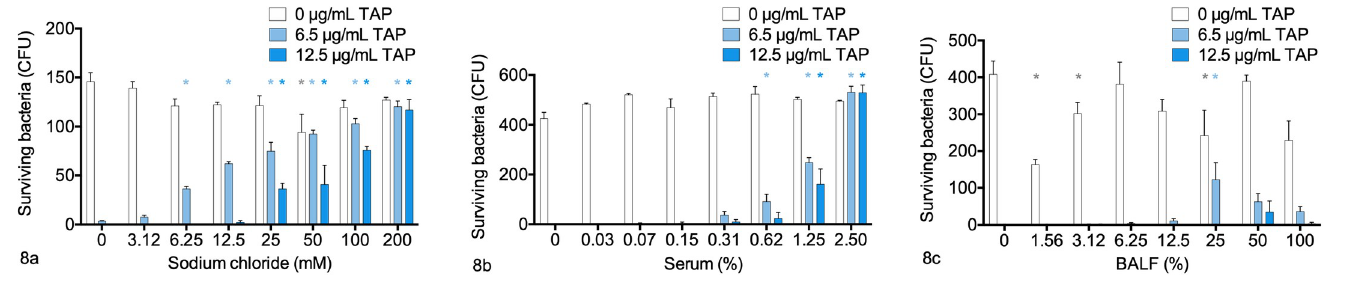
Fig 8. Effects of serum, sodium chloride, and bronchoalveolar lavage fluid (BALF) on survival of Mannheimia haemolytica B158 in the presence of tracheal antimicrobial peptide (TAP). Differing concentrations of (A) sodium chloride, (B) serum, or (C) concentrated BALF (diluted in monobasic sodium phosphate buffer) were mixed with 2 different concentrations of TAP or buffer before incubating with M . haemolytica for 1 hour. The mixtures were inoculated onto blood agar plates, and colonies were counted the next day. � P < 0.05 compared to no sodium chloride, 2-way ANOVA, n = 3 replicates per group.